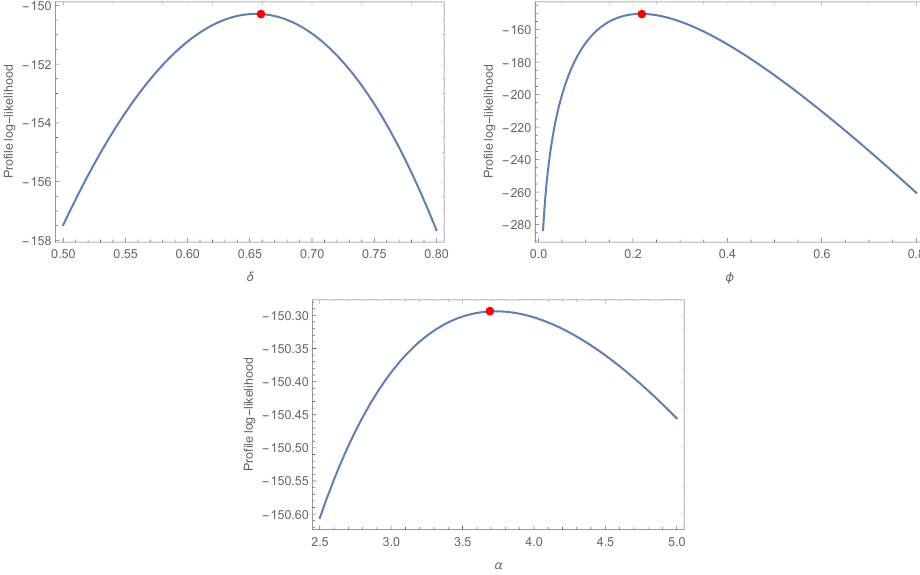
Figure 4. The profiles of the log-likelihood functions of ˆ δ MLE , ˆ φ MLE , and ˆ α MLE using the first engineering data